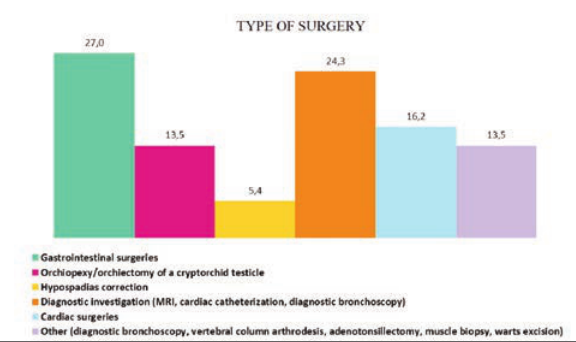
Figure 2. Type of surgery and diagnostic procedures in 11 Italian patients with